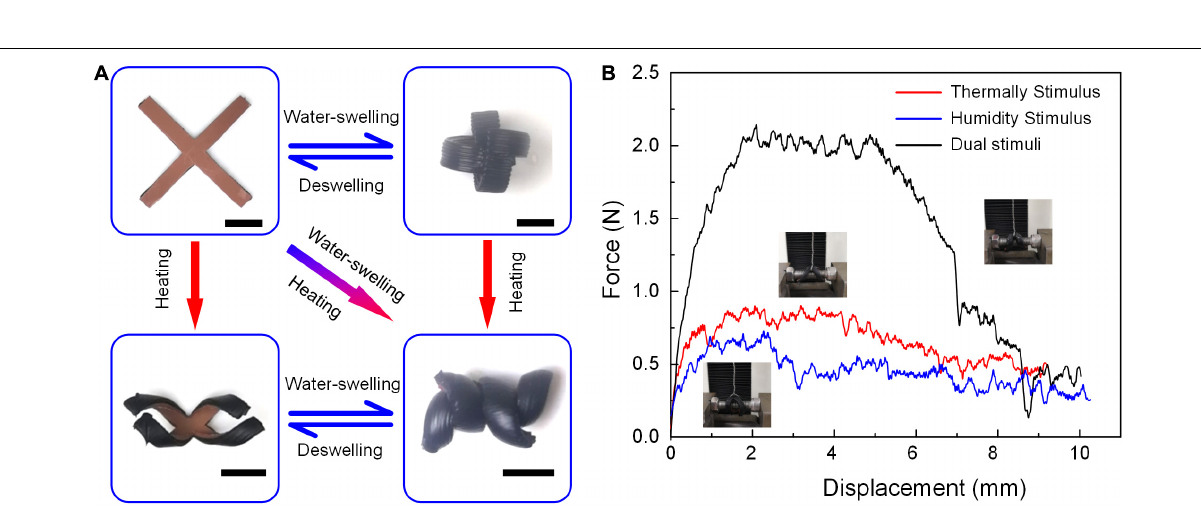
FIGURE 11 | Deformation of a PU-SMPVC bilayer structure composed of four branches with a quarter circle shape in response to different stimuli. Each branch is obtained by rotating the adjacent branch clockwise.